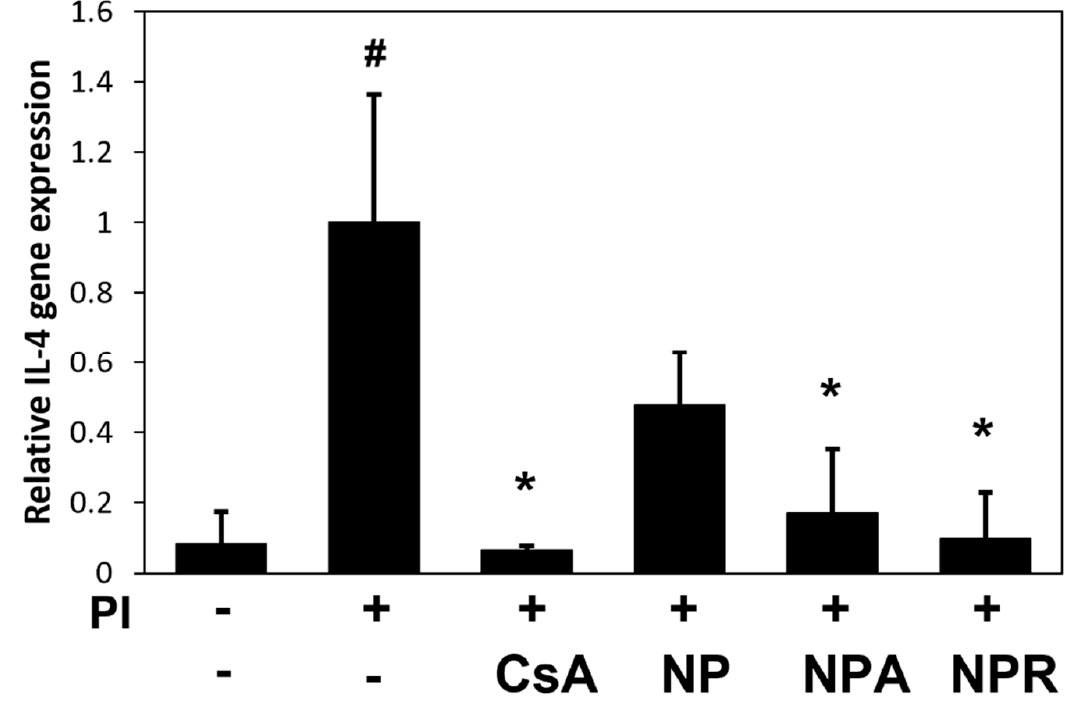
Figure 1. IL-4 inhibitory effect by NP, NPA, and NPR extracts. IL-4 expression was determined by qPCR versus GAPDH. Results are expressed as means ± SDs for the in vitro study of 2 to 3 inde- pendent experiments. # p < 0.05 vs. untreated control group; * p < 0.05 vs. PI-treated cells. CsA: cyclo- sporin-treated group; NP: PI plus N. peltata whole extract-treated group; NPA: PI plus N. peltata aerial extract-treated group; NPR: PI plus N. peltata root extract-treated group.